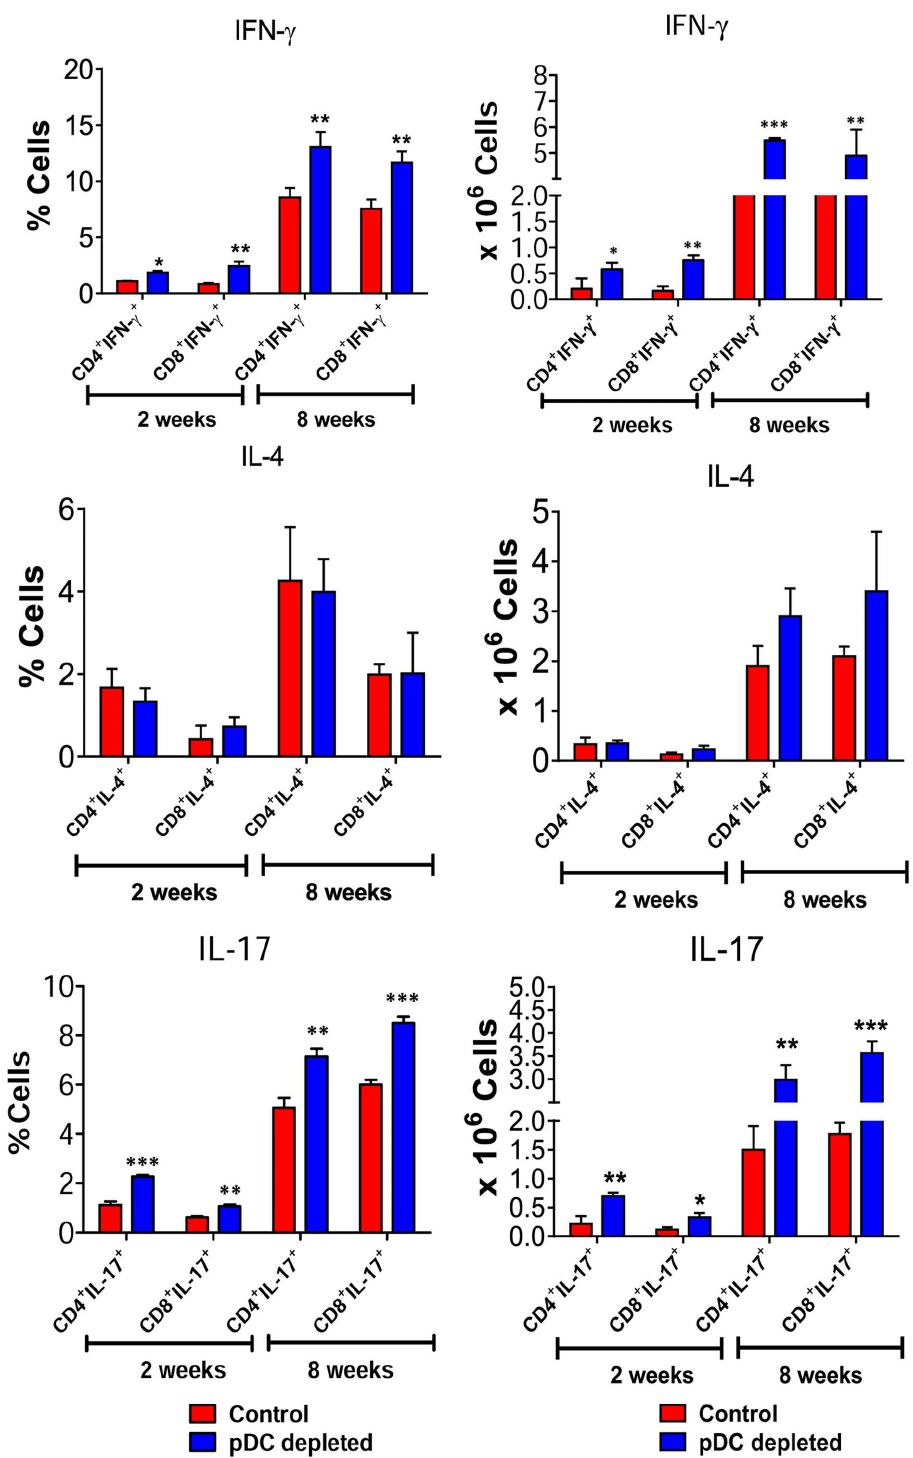
Fig 6. pDC depletion increasesthe differentiation of type 1 and type 17 CD4 + and CD8 + T cells. The presenceof IL-17 + , IL-4 and IFN- γ + in CD4 + and CD8 + T cells in the LILs was assessed by intracellular cytokinestaining by flow cytometry at weeks 2 and 8 after infection. Lungcells were stimulated in vitro with PMA/ionomycin for 6 hours and subjectedto intracellular staining for IL-17 and IFN- γ . The lung infiltrating lymphocytes were gated by FSC/SSC analysis. Lymphocytes were gated for CD4 or CD8